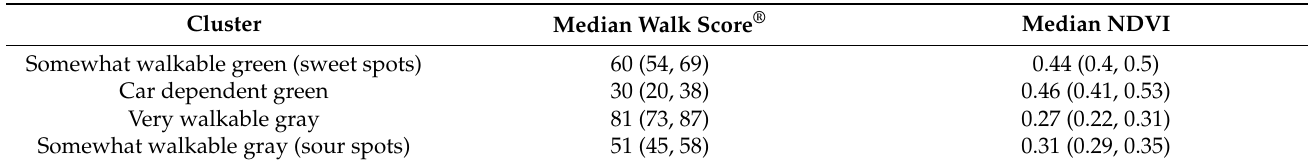
Table 4. Variation of median Walk Score ® and NDVI across the four clusters. Figures in brackets represent 25th and 75th percentiles, respectively.